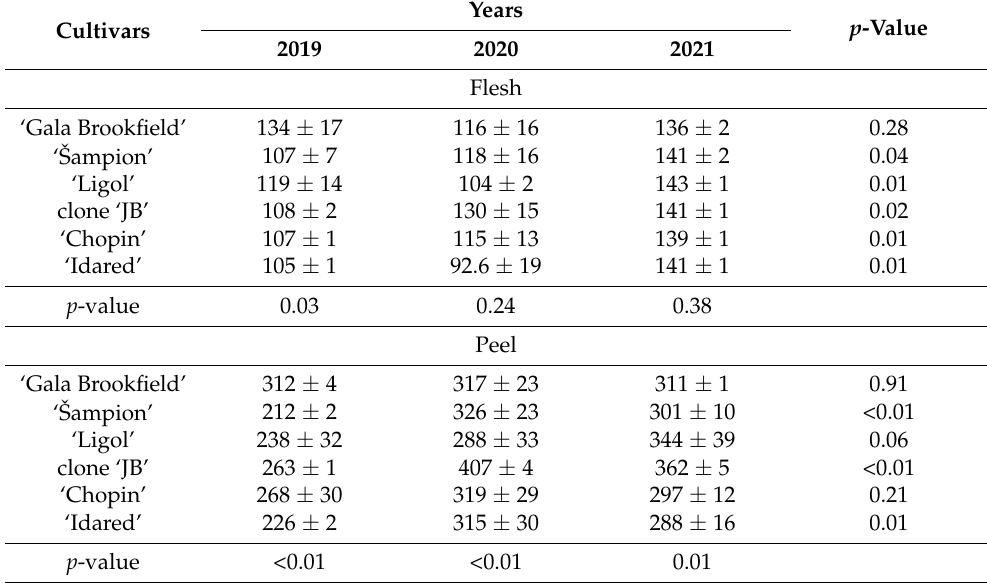
Table 9. The values of flavonols (mg · 100 g − 1 FW) for the flesh and peel of apples depending on cultivars and years of testing.